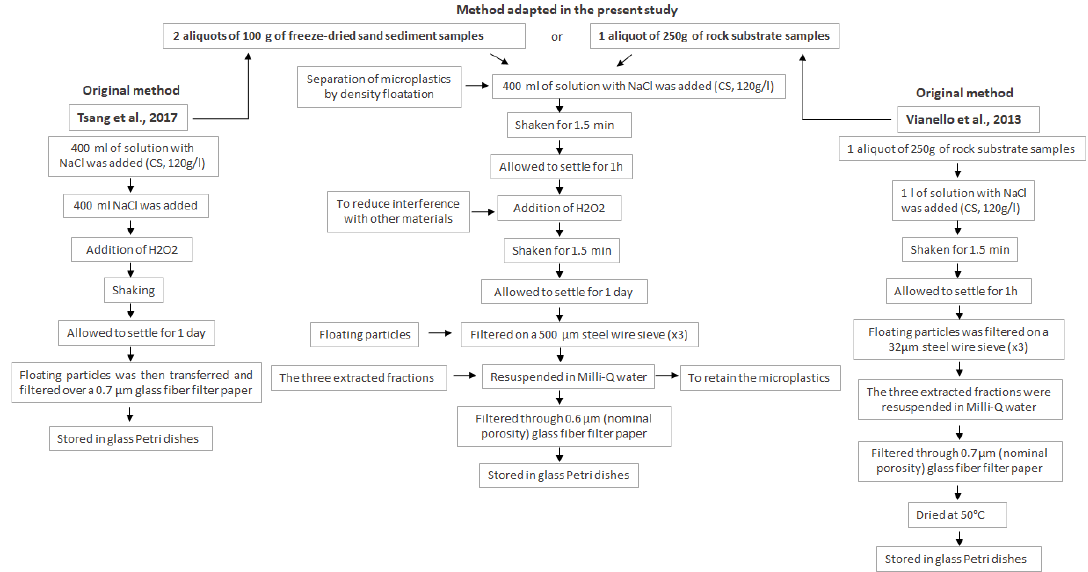
Figure 2 . Comparison of methods (from literature Tsang et al., 2017 [29] and Vianello et al., 2013 [26] and the method adapted in the present study).